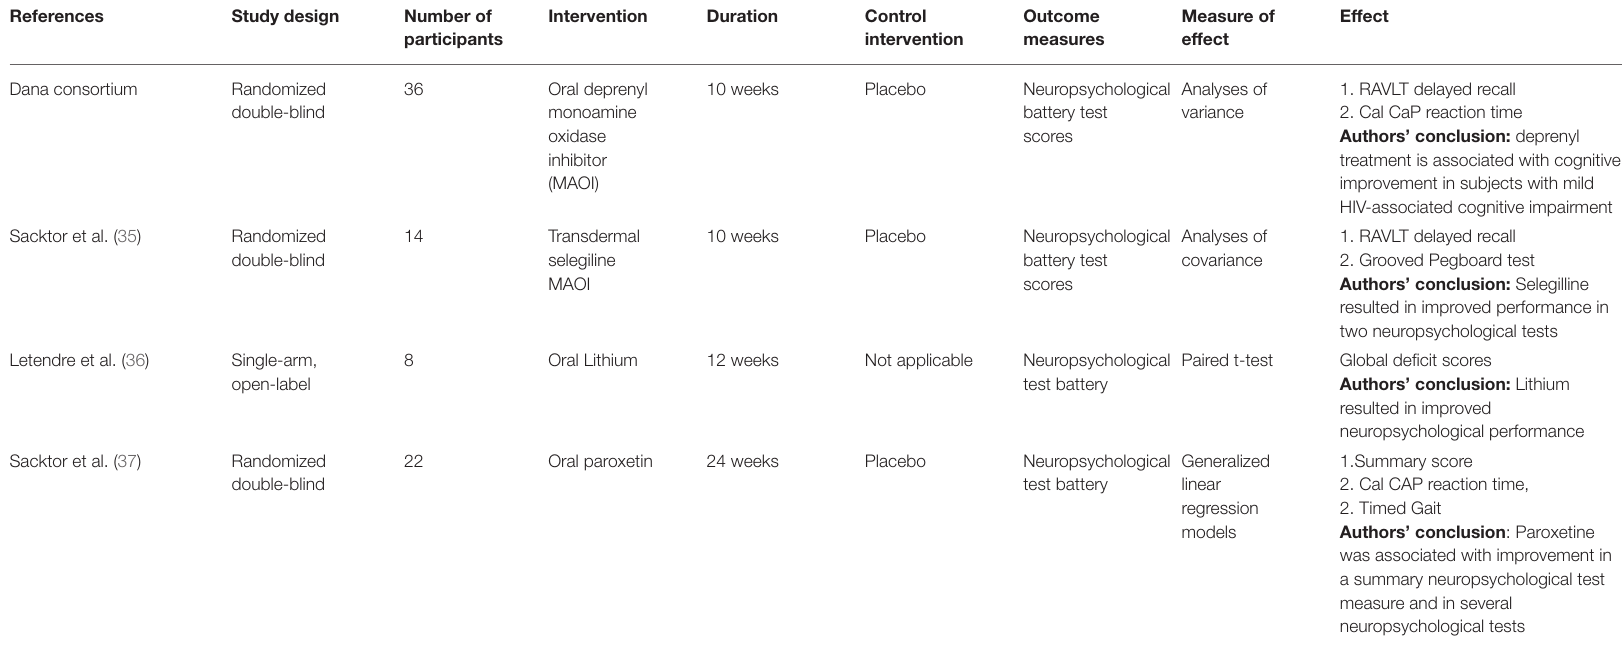
TABLE 1 | Previous trials of antidepressants for